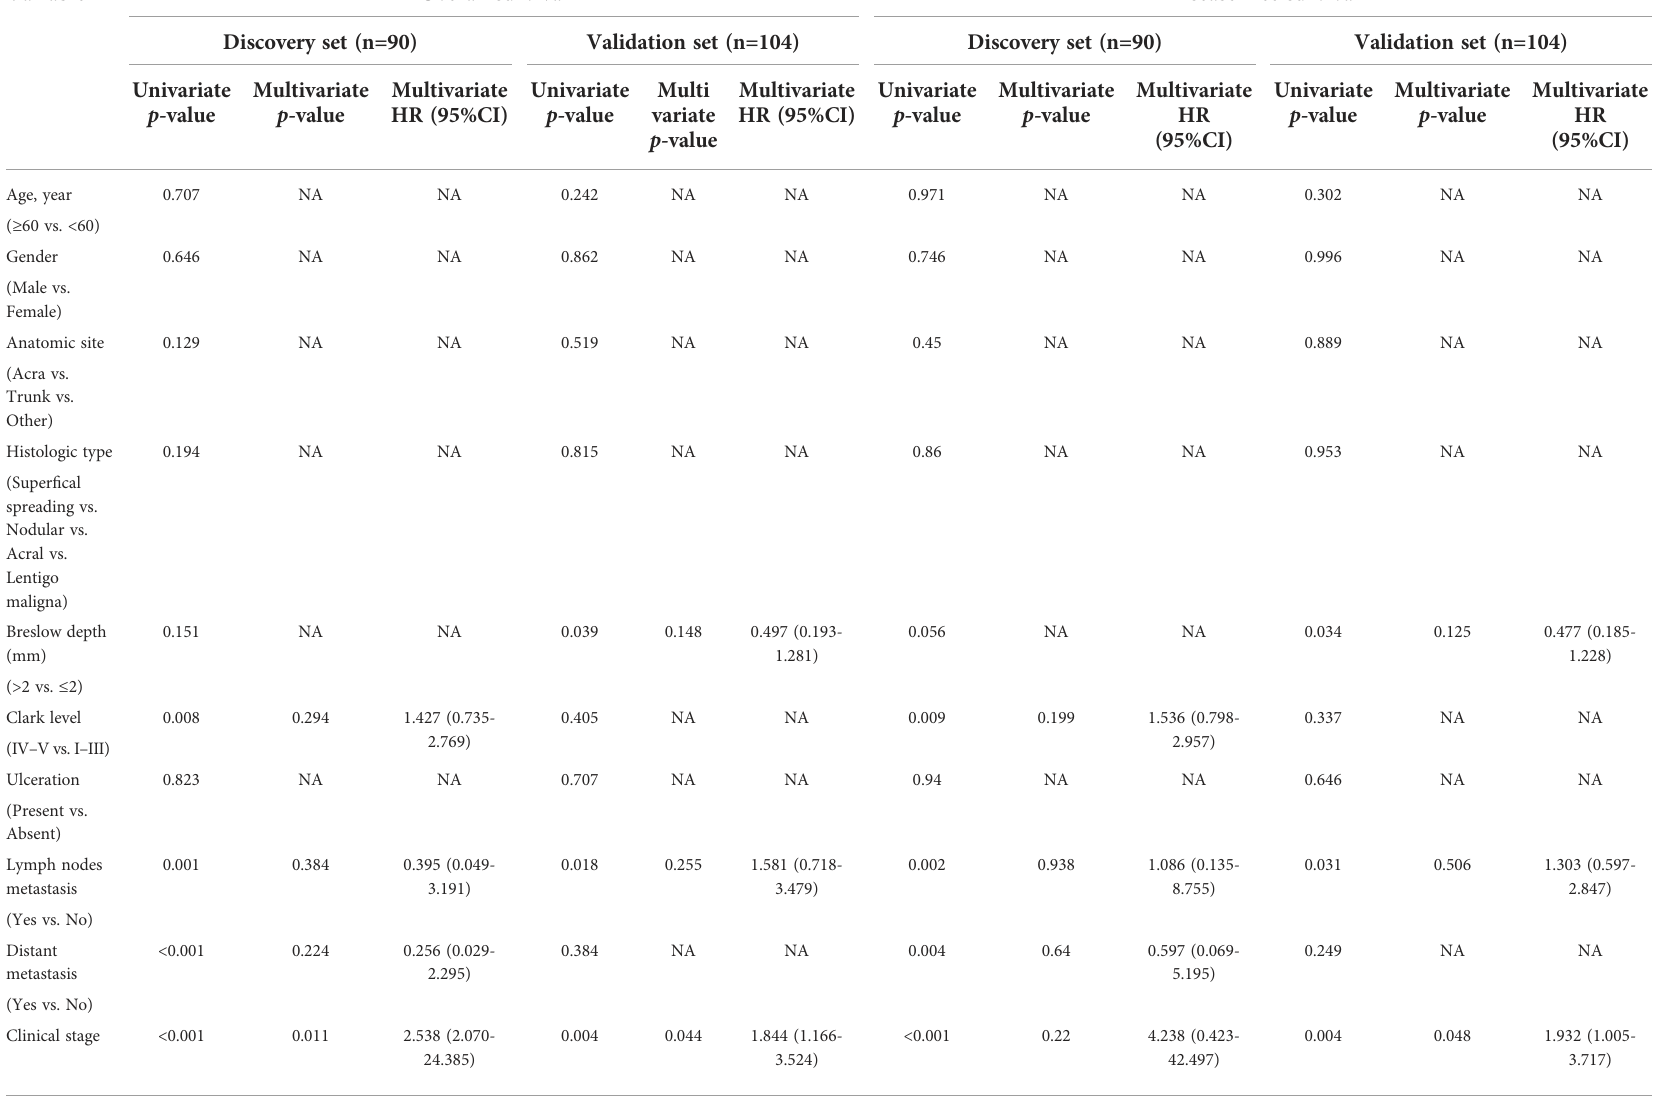
TABLE 2 Univariate and multivariate analysis of prognostic factors associated with OS and